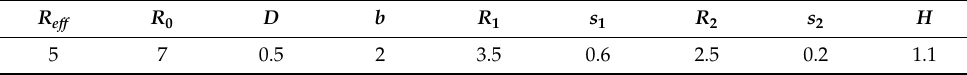
Table 1. Dimensional parameters of the optimized sensor (unit: mm).